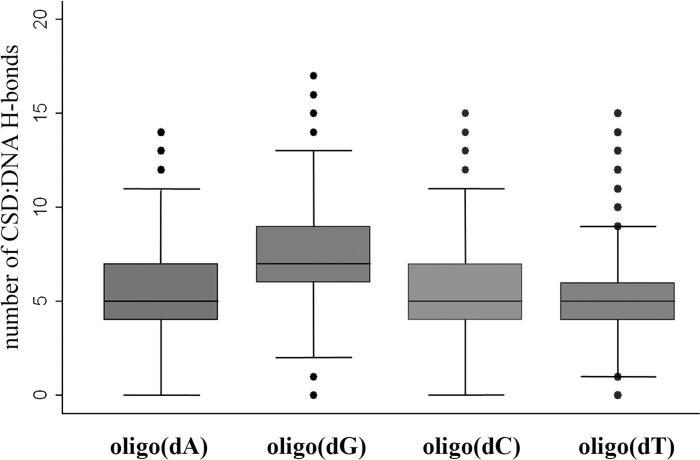
Number of intermolecular H-bonds in the complexes of CSD with different desoxyribooligonucleotides.